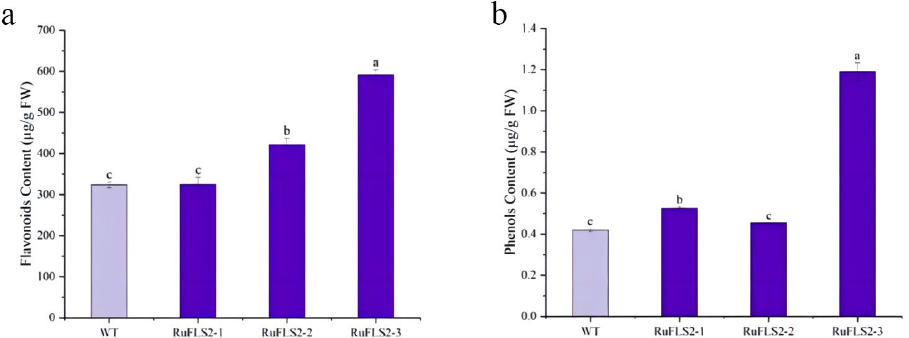
Figure 6. Flavonoid ( a ) and phenol ( b ) contents in WT and RuFLS2-overexpressing tobacco. WT represents wild-type tobacco. RuFLS2-1, RuFLS2-2 and RuFLS2-3 represent three different transgenic tobacco lines. Significant differences between means ( p < 0.05) are indicated by lowercase letters (a, b and c) above the bars.